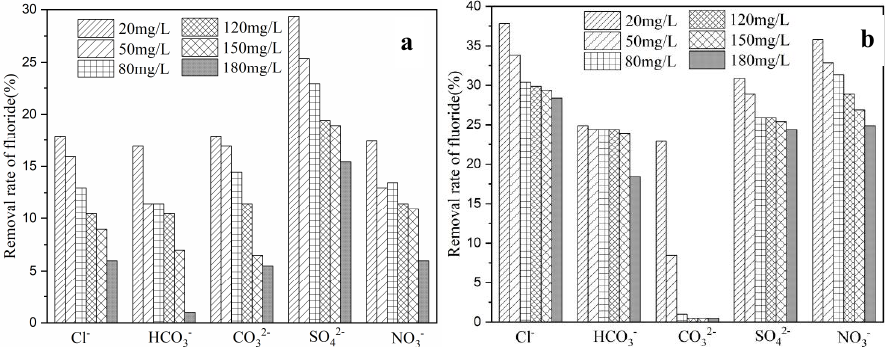
Figure 9. Effect of coexisting anions on F - adsorption by MnOOH-supported AA ( a ) and AA ( b ).